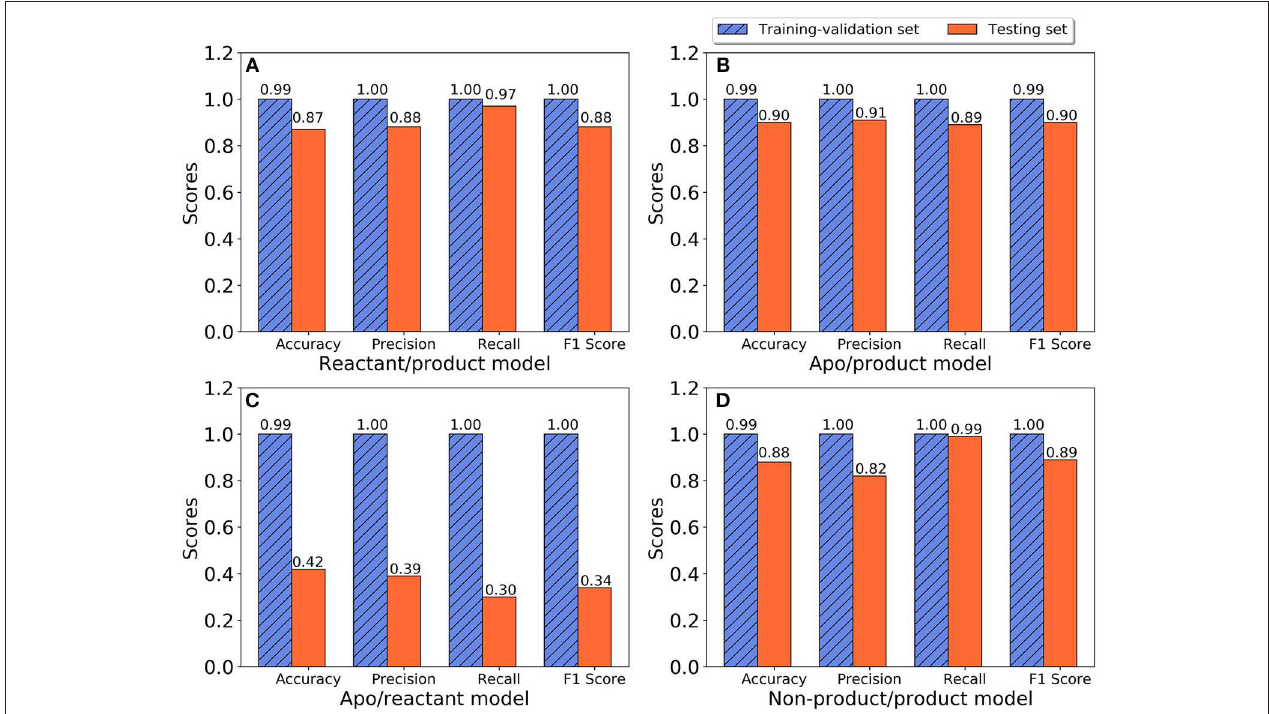
FIGURE 5 | The performance of random forest classification models in accuracy, precision, recall, and F1 scores for training-validation set (blue shadow) and testing set (red). (A) Reactant and product states model; (B) Apo and product states model; (C) Apo and reactant states model; (D) Non-product and product states